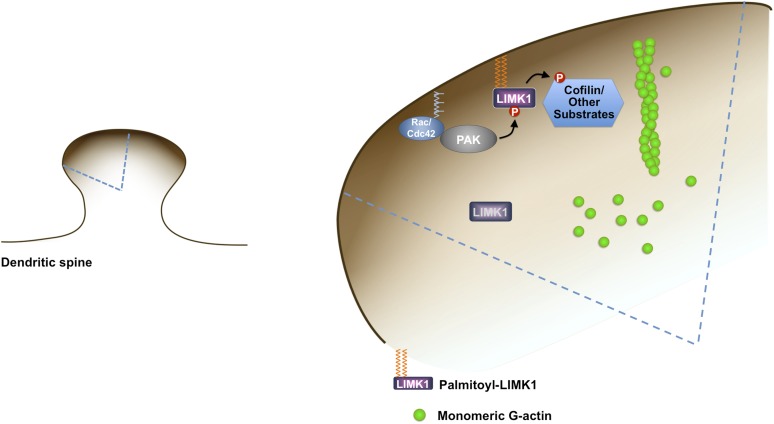
Model of palmitoyl-LIMK1-dependent control of actin dynamics in dendritic spines.Dendritic spine schematic (left panel) with the indicated region expanded (blue boundary) to the right. Palmitoylation targets LIMK1 to the spine membrane, where it is phosphorylated by membrane-bound activators such as Rac/Cdc42/PAK. In contrast, any non-palmitoylated LIMK1 in the spine ‘core’ remains inactive. By governing both LIMK1 localization and activation, palmitoylation may also facilitate local, juxtamembrane-specific phosphorylation of cofilin and/or other LIMK1 substrates to enhance the spatial control of actin filament turnover in spines. For clarity, other actin regulatory processes such as filament capping and branching are not shown.